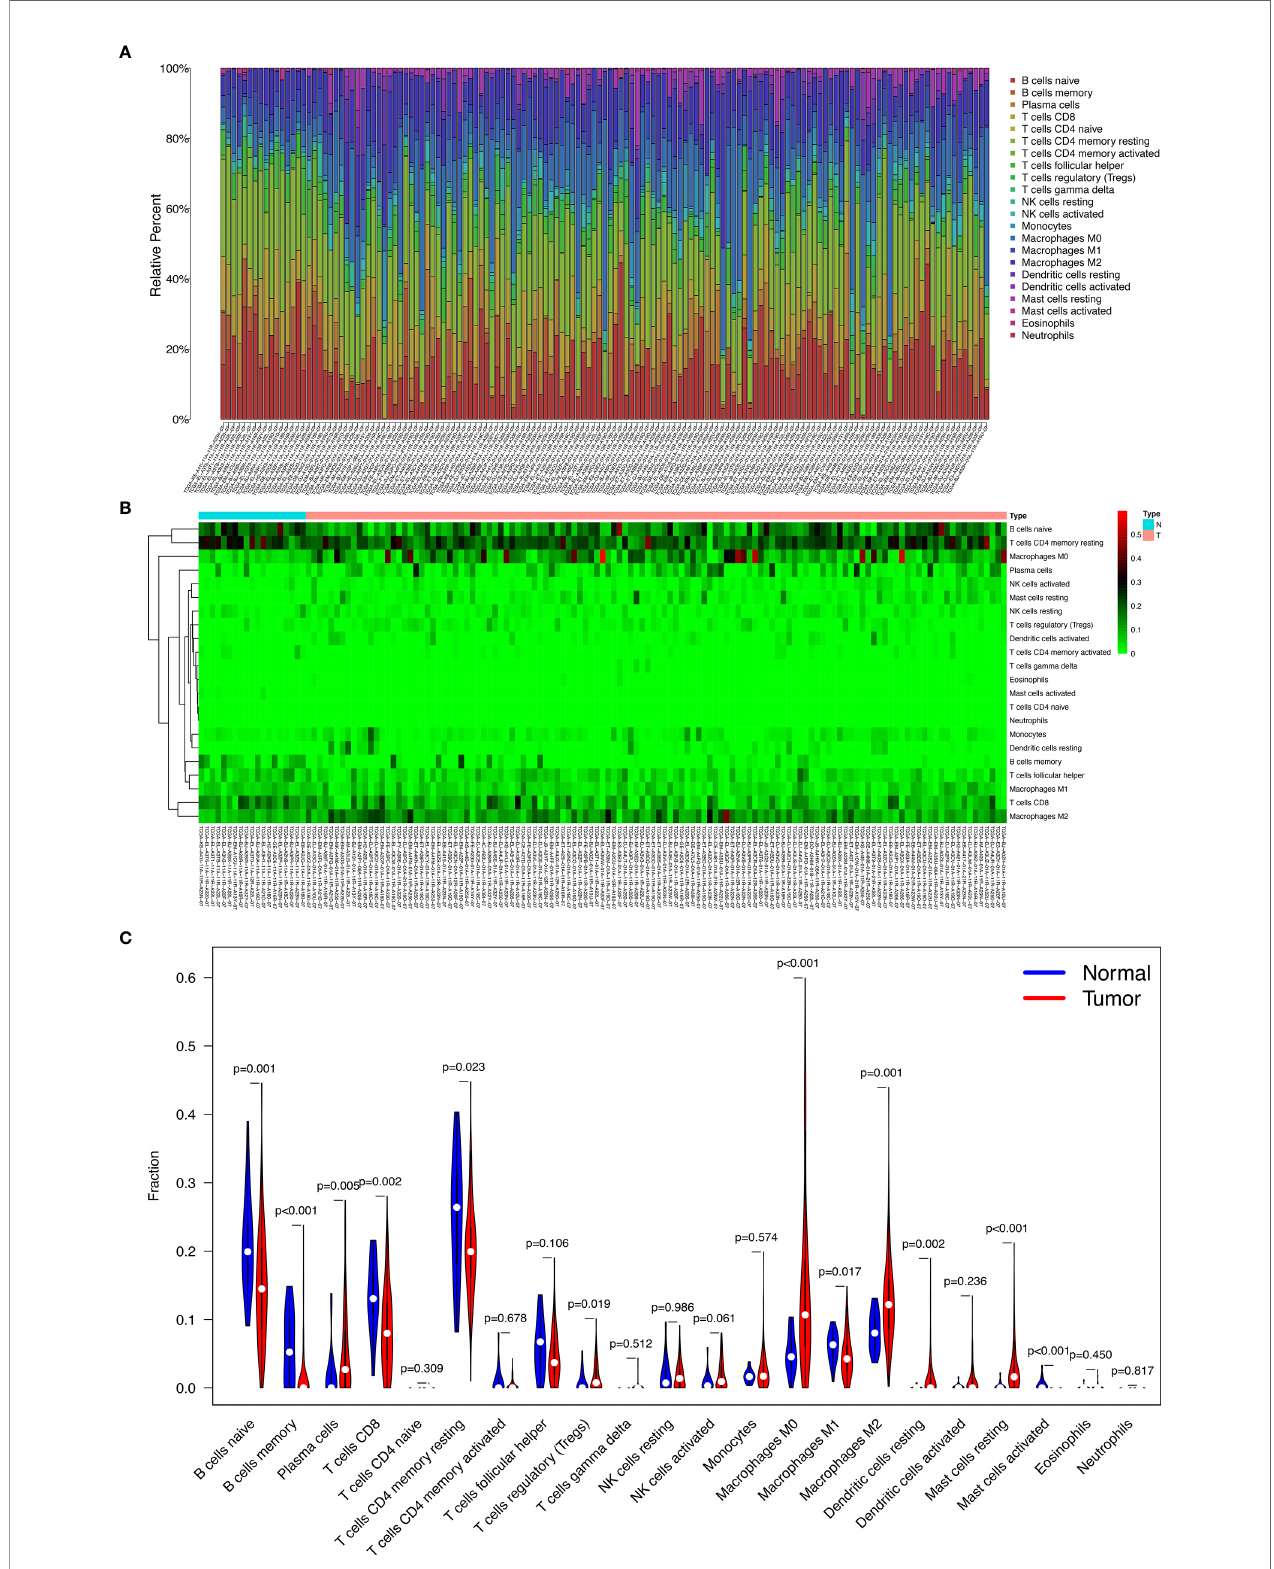
FIGURE 4 | The proportion of the 22 immune cells detected by the CIBERSORT algorithm (A, B) ; the results of the Wilcoxon rank-sum test (C)